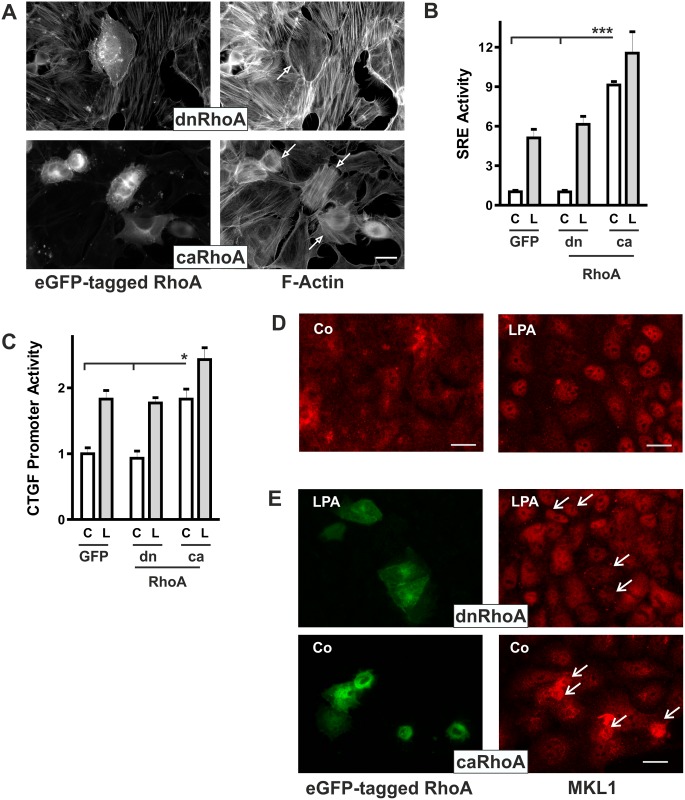
Overexpression of activated RhoA activates SRE activity and enhances CTGF promoter activity.(A) HKC-8 cells were transfected with constitutively active RhoA (G14V) or dominant negative RhoA (T19N) coupled to eGFP. 24 h after transfection, cells were stimulated with LPA (10 μM) for 1 h. Actin fibers were visualized with PromoFluor phalloidin. Arrows indicate transfected cells. Scale bar: 20 μm. (B) HKC-8 cells were transfected with eGFP-coupled dominant negative (dn) or constitutively active (ca) Rho GTPases, or eGFP (-) as control together with luciferase-coupled SRE constructs. Expression of cotransfected beta galactosidase was used as reference. Cells were stimulated with LPA (L, 10 μM) for 4 h. Data shown are means ± SD of 3 independent experiments performed with duplicate transfections. In each experiment the mean of the unstimulated control values was set to 1. SRE activity in caRhoA in control cells (C) was significantly increased (p < 0.001); ANOVA with Tukey’s multiple comparison test. (C) HKC-8 cells were transfected with eGFP-coupled constitutively active RhoA (caRhoA) or eGFP (Co) and luciferase-coupled 4.5 kb CTGF promoter constructs. Cotransfected Beta galactosidase was used as reference. Data are means ± SD of 3 experiments performed in duplicates. The mean values of control cells were set to 1. CTGF promoter activity was significantly higher in RhoA transfected cells (p < 0.05, ANOVA with Tukey’s multiple comparison test.) (D) HKC-8 cells were transfected with eGFP. 24 h after transfection the cells were stimulated with LPA for 1 h. MKL1 was detected by indirect immunofluorescence. Scale bar: 20 μm. (E) HKC-8 cells were transfected with eGFP-tagged dominant negative RhoA (T19N) constitutively active RhoA (G14V) (green) and stimulated with LPA for 1 h. Expression of MKL1 was detected by immunocytochemistry (red). Scale bar: 20 μm.